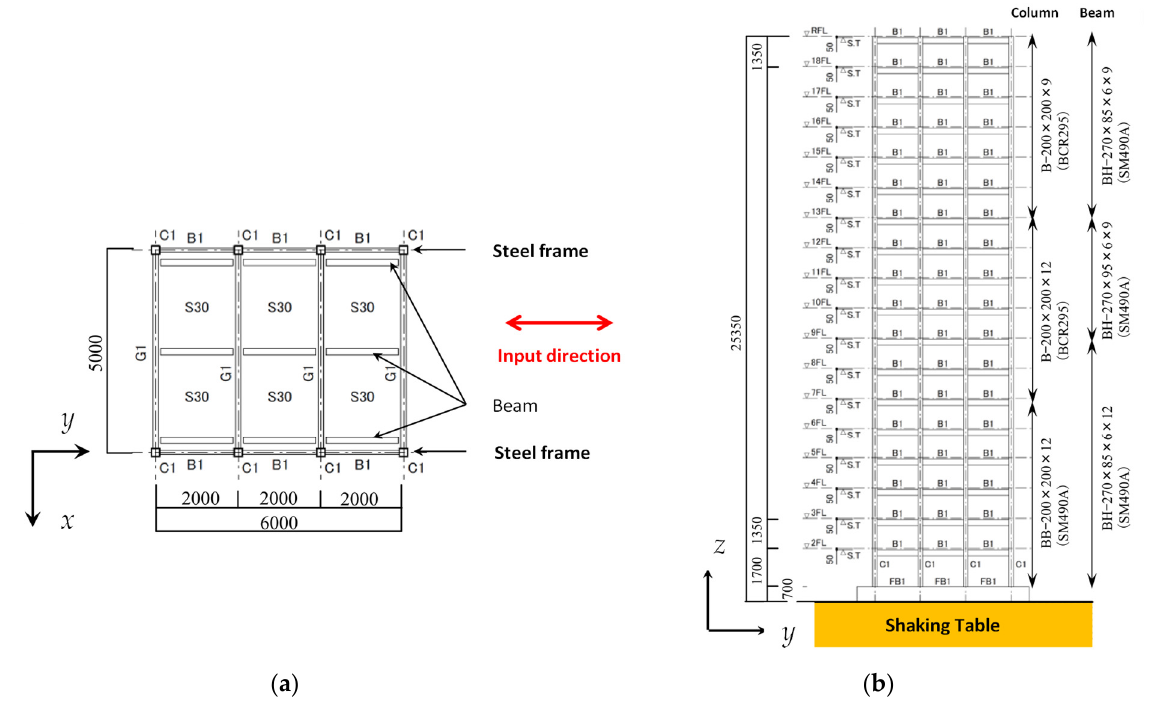
Figure 3. Framing plan and elevation of a 1/3-scale steel building: ( a ) Framing plan; ( b ) framing elevation plan. Table 3. Results of shaking table test and its safety classification. Exp.